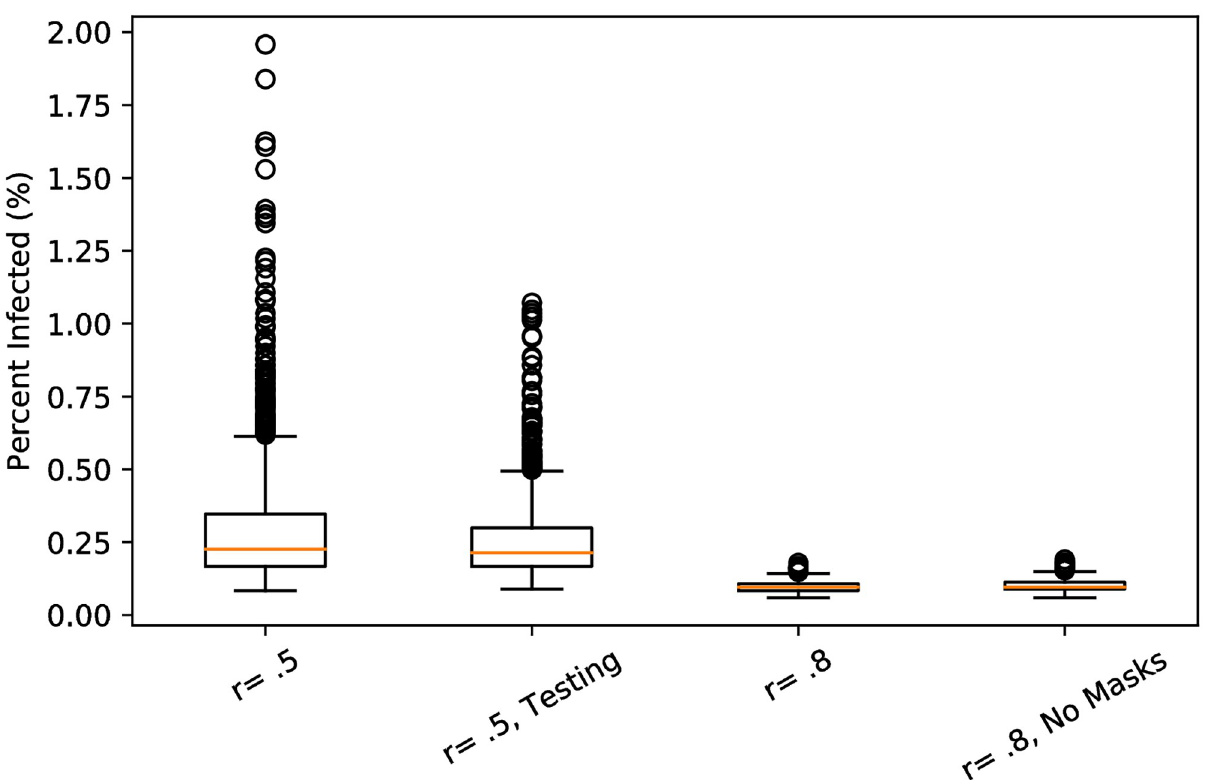
Fig 1. The percent of the population infected ( y -axis) in 1000 simulated 15-week semesters per scenario. Each scenario assumes that 100% of the campus population is vaccinated. From left to right we consider the scenarios of: 50% vaccine effectiveness ( r = .5), 50% vaccine effectiveness with screening testing ( r = .5, Testing), 80% vaccine effectiveness ( r = .8), and 80% vaccine effectiveness with no facemask use on campus ( r = .8, No Masks).